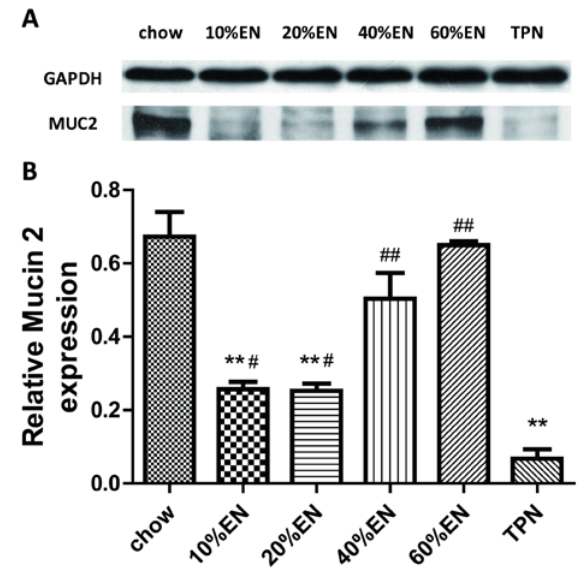
Figure 4. Relative density of mucin 2 (MUC2) in the ileal tissue. ( A ) Representative bands of MUC2, as detected by Western blotting; ( B ) MUC2 levels in the ileal tissue. Data are presented as the mean ± standard error of the mean (SEM). ** p < 0.001 vs. chow. # p < 0.05 vs. TPN. ## p < 0.001 vs. TPN. EN: enteral nutrition; TPN: total parenteral nutrition;